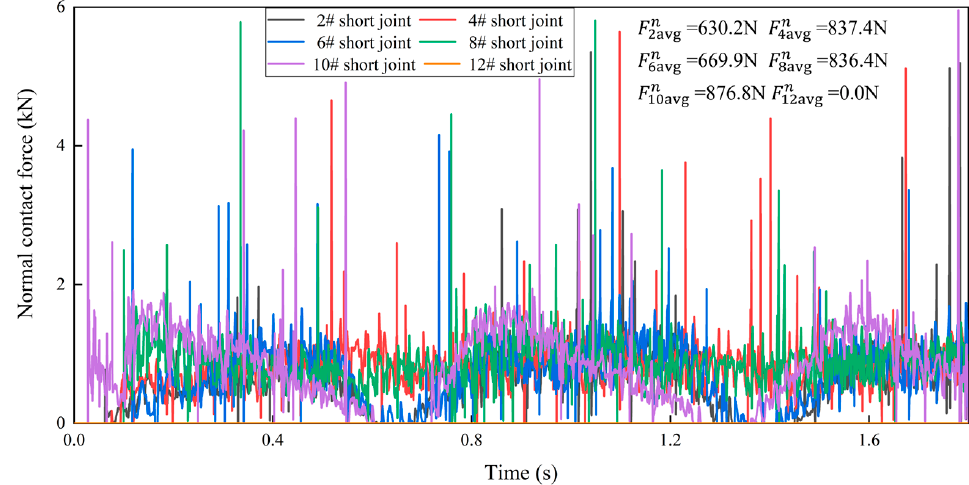
Figure 10. Variation curve of normal contact force between flexible drill pipe and guide tube.